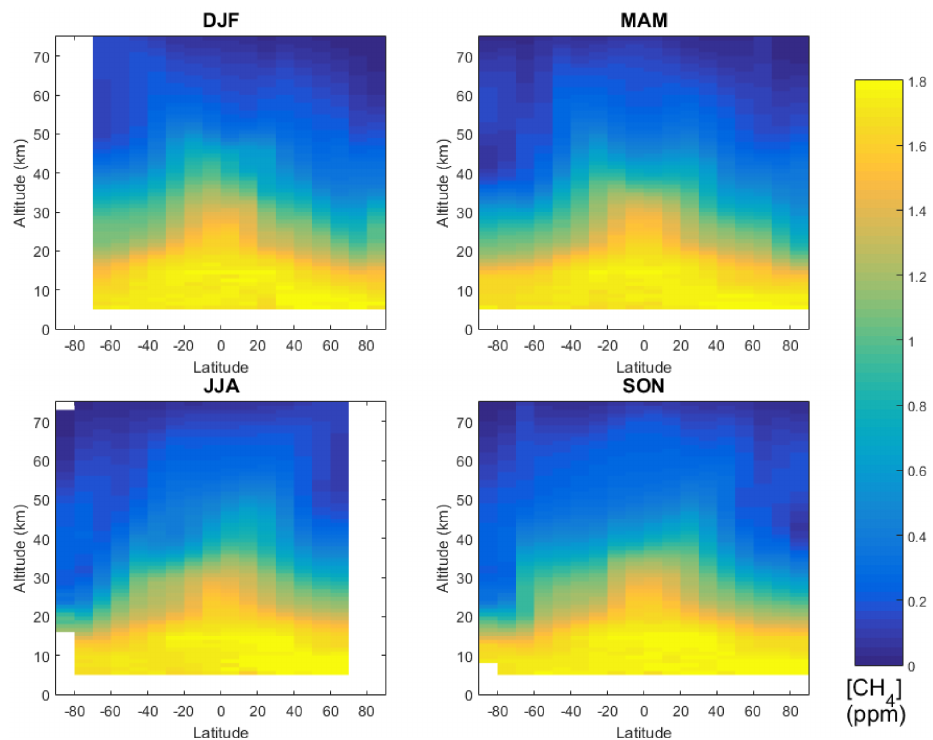
Figure 3. ACE total methane concentration by